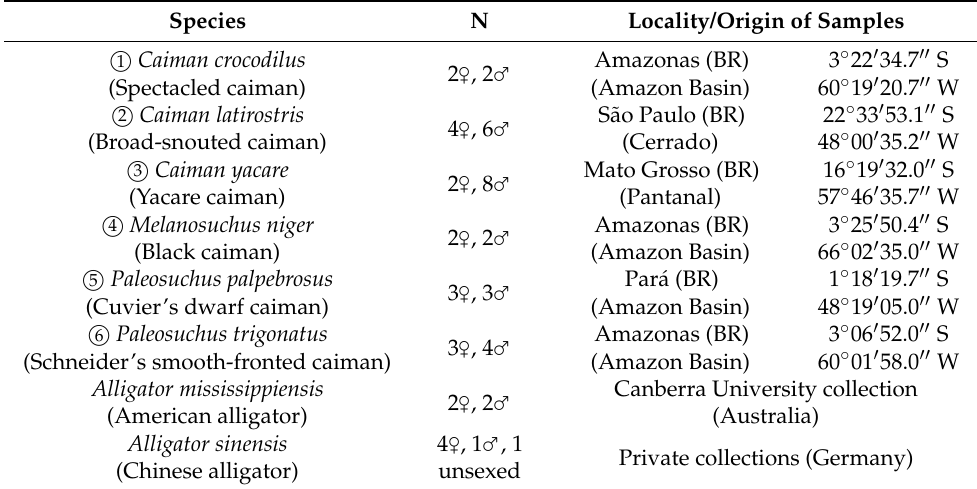
Table 1. Species, sample size (N), sex and locality of the analyzed